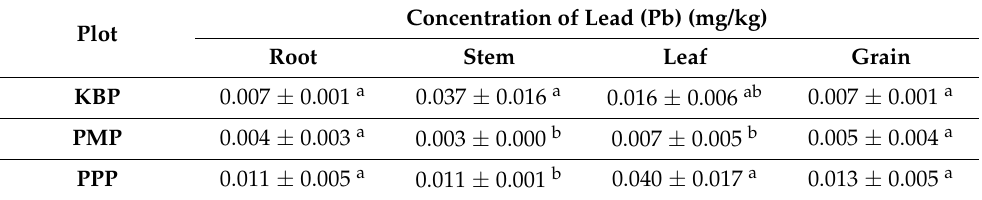
Table 5. Concentration of lead in different parts of paddy plants collected from Kelantan. Plot